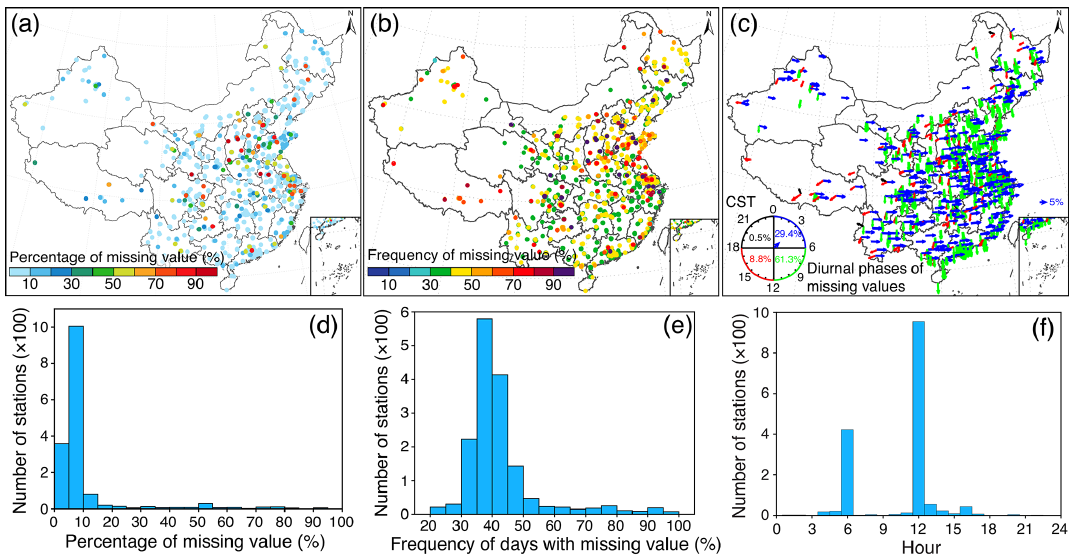
Figure 3. Statistics associated with missing values present in the site-specific hourly PM 2 . 5 concentration record since the time of the release of the first PM 2 . 5 observation onward. (a) Percentage of missingness in each PM 2 . 5 record, (b) frequency of days with missing values, (c) diurnal phases of the maximum frequency of missing values occurring within 24h, (d–f) histograms for (a–c) , respectively. The arrow direction in (c) indicates the local time (China standard time, CST) at which missing values occurred most frequently and the arrow length shows the magnitude of frequency. The varying diurnal phases of missing values are represented by different colors: blue (00:00–06:00CST), green (06:00–12:00CST), red (12:00–18:00CST), and black